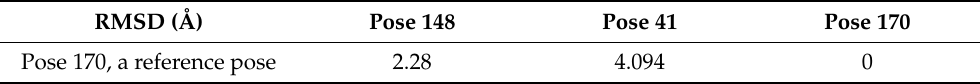
Table 3. The values of RMSD between pose pairs, with acarbose as a reference